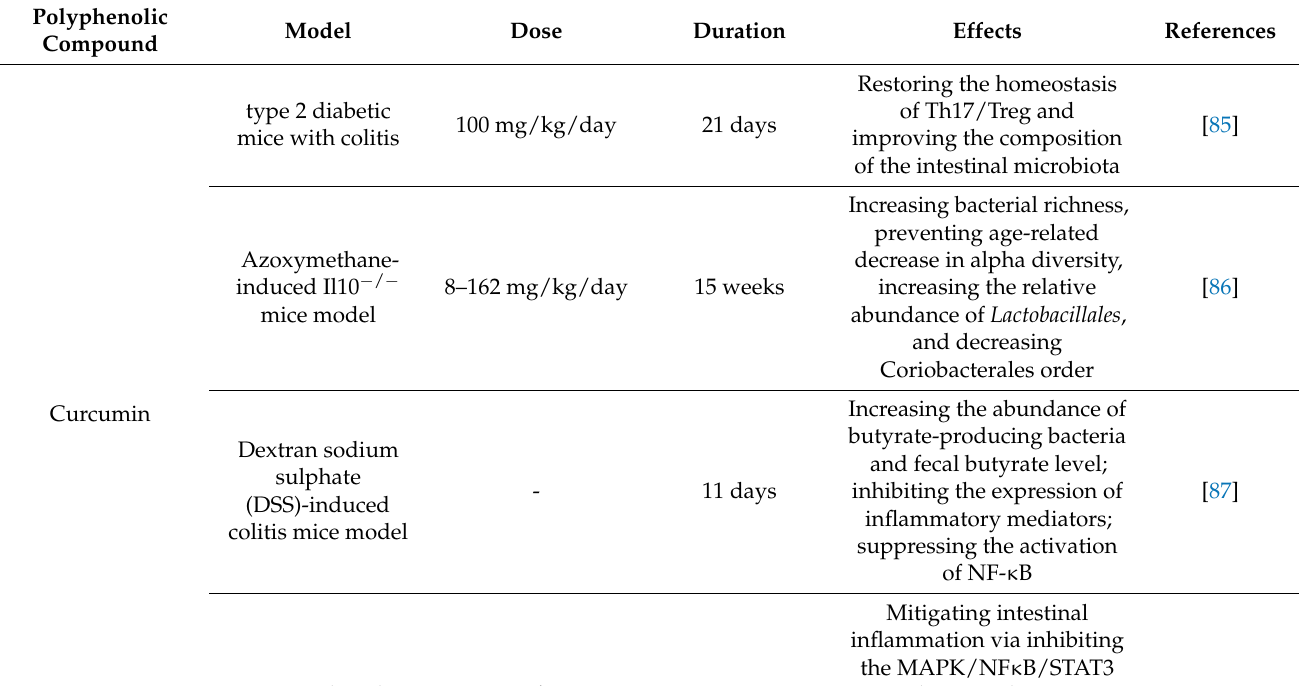
Table 1. Effects of polyphenols on oxidative stress and inflammation by modulation of gut microbiota in